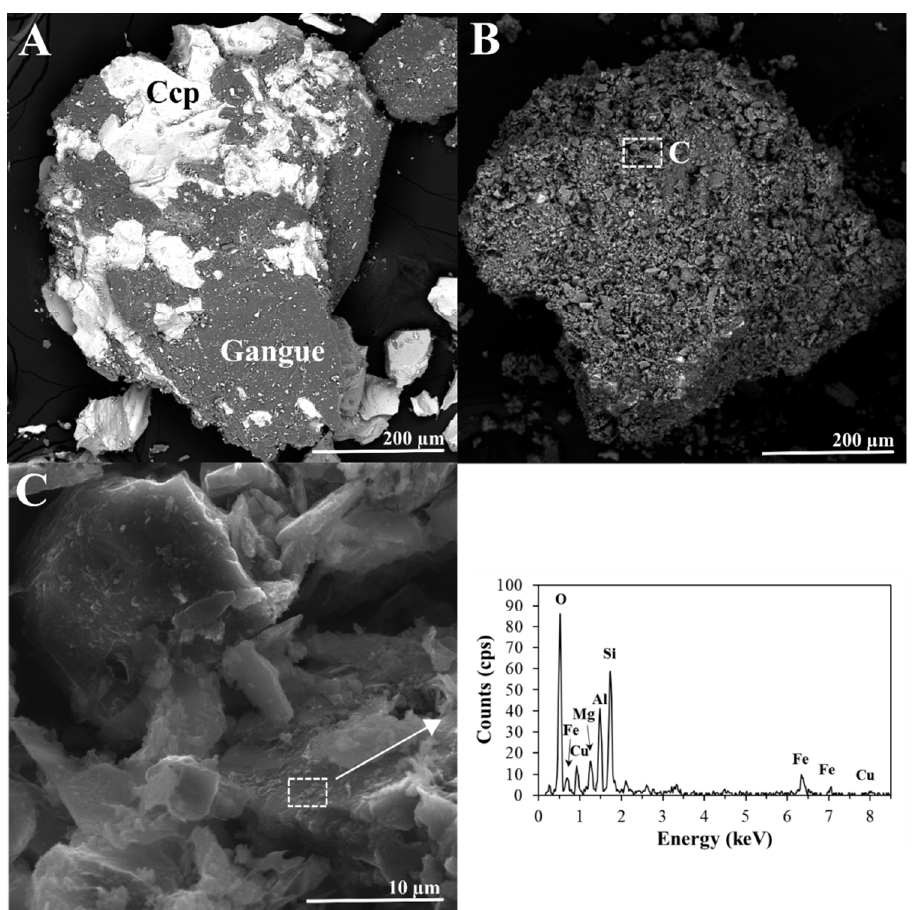
Figure 4. Back-scattered electrons-Scanning electrons microscopy (BSE-SEM) micrograph (HV:20 kV): ( A ) Sulfide ore highlighting the presence of the chalcopyrite (Ccp) mineral and ( B ) weathered ore agglomerate showing the heterogenous small particles composition. Scanning electrons microscopy- Energy dispersive spectroscopy (SEM-EDS) (HV:20 kV) micrograph: ( C ) Elemental composition of a clay mineral surface highlighting the presence of Cu with the elements O, Fe, Mg, Al, Si.